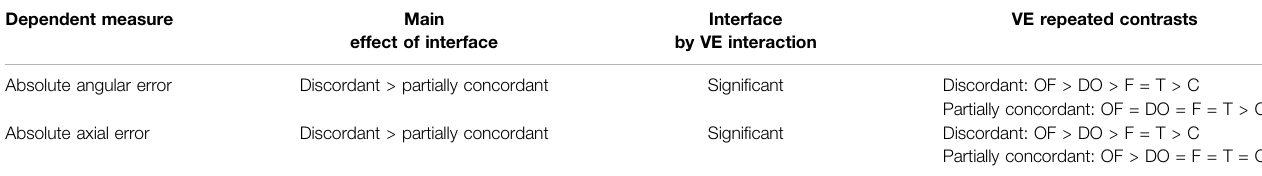
TABLE 1 | Summary of key fi ndings from the statistical analyses. For repeated contrast results, OF, open fi eld; DO, drop-off; F, fence; T, texture; and C, classroom. Dependent measure Main Interface effect of interface by VE